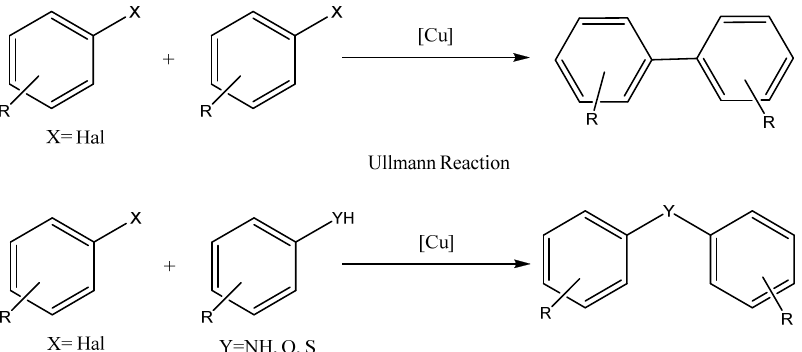
Scheme 1. Schematic representation of the Ullmann reaction and Ullmann condensation.